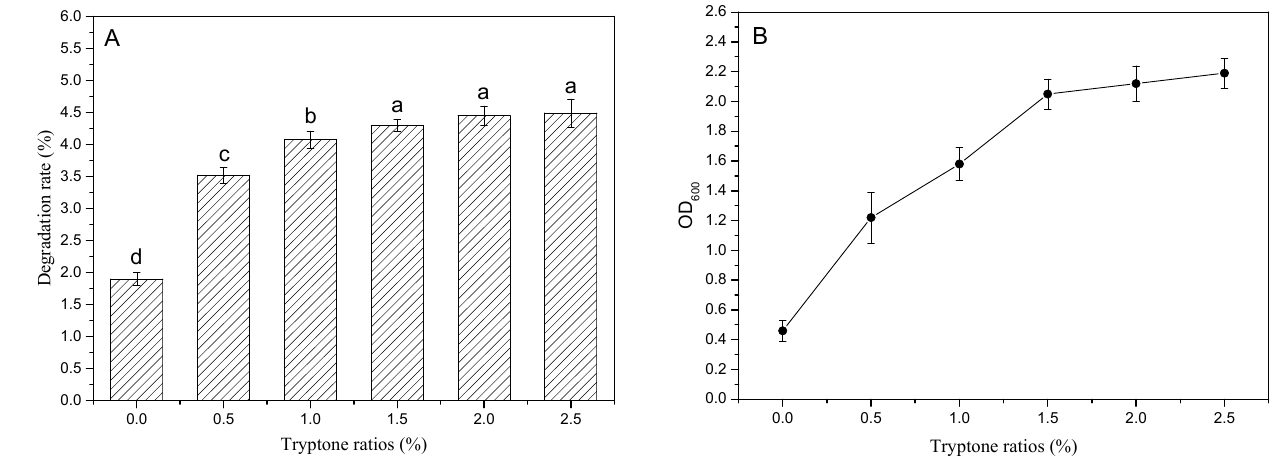
Figure 3. Effect of different ratios of tryptone on the degradation rate of PBAT film ( A ) and the change of biomass (OD 600 ) in the medium ( B ); a–d are symbols indicating the significance of the difference.